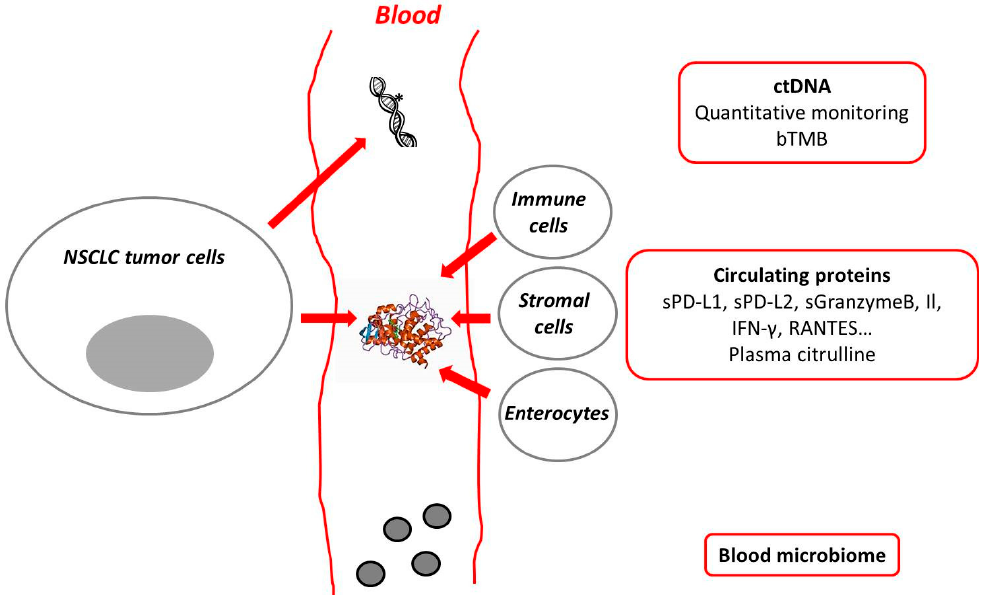
Figure 1. Plasma biomarkers and immune checkpoint inhibitors in non-small cell lung cancer.